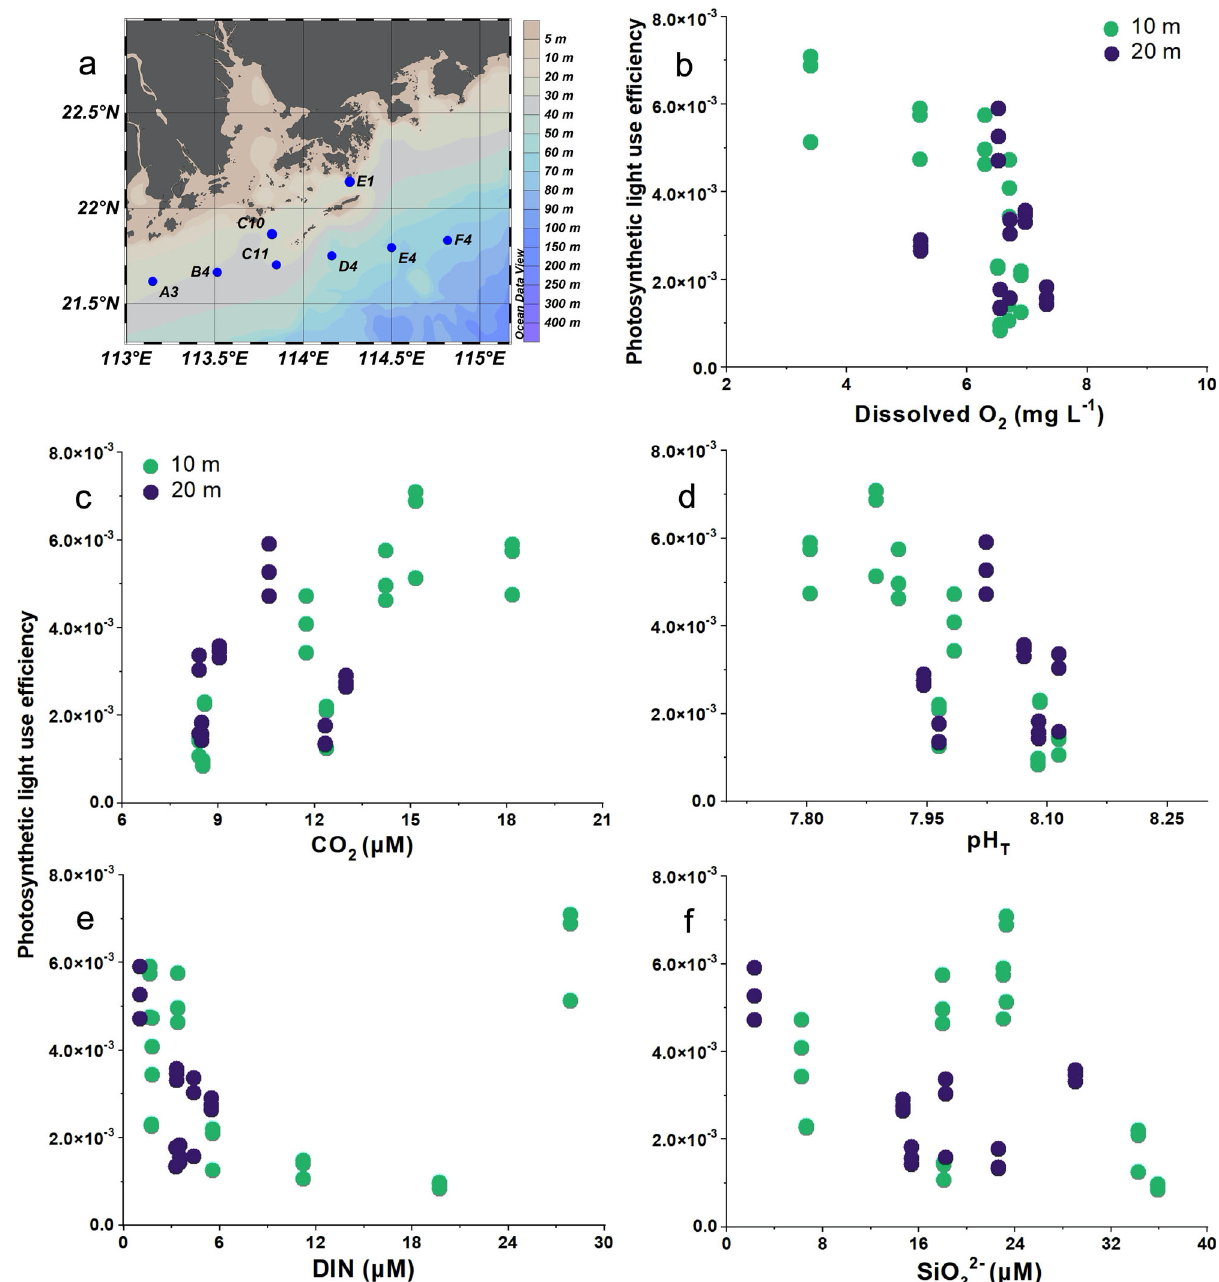
Fig. 1 Field investigation of the Pearl River Estuary in the northern South China Sea. Photosynthetic light use ef fi ciency [ μ mol C ( μ g Chl a ) − 1 h − 1 ( μ mol photons m − 2 s − 1 ) − 1 ] of phytoplankton assemblages in stations of Pearl River Estuary ( a ) as a function of dissolved O 2 levels (mg L − 1 ) ( b ), CO 2 levels ( μ M) ( c ), pH T ( d ), DIN (NO 3 − + NO 2 − + NH 4 + , μ M) ( e ) and SiO 3 2 − ( μ M) ( f ). Samples were collected from 10 m (Green) and 20 m (Purple) depths in stations (Blue) of the Pearl River Estuary in the northern South China Sea (June 2015), detailed parameters for the fi eld observations at the stations are shown in the Supplementary Table 1. Signi fi cant ( P < 0.0001) negative ( b , d ) and positive ( c ) correlations and non-signi fi cant ( e , f , P = 0.6671, 0.0707, Pearson correlation analysis, two-tailed) relationships with O 2 ( b ), CO 2 ( c ), pH T ( d ), DIN ( e ) and SiO 3 2 − ( f ) are shown in Supplementary Table